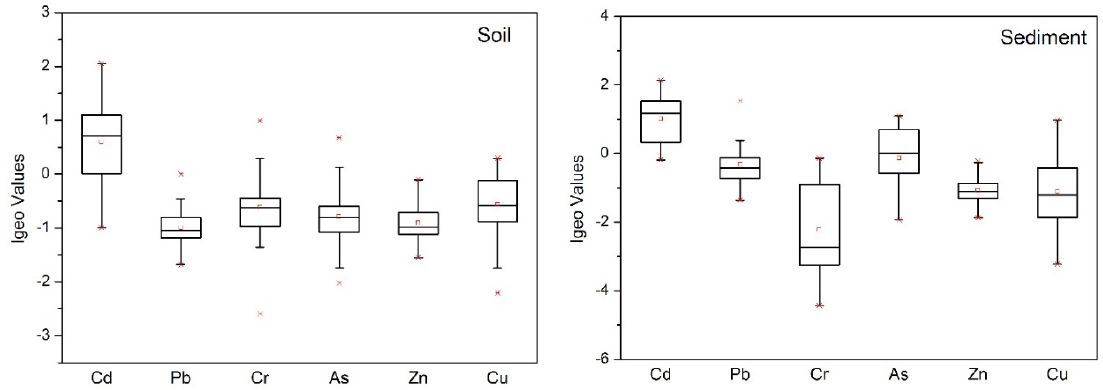
Figure 3. The Igeo values of potentially toxic elements in soil and sediment (The upper × indicates 95th percentile and the lower × indicates 5th percentile value, respectively □ indicate median value).